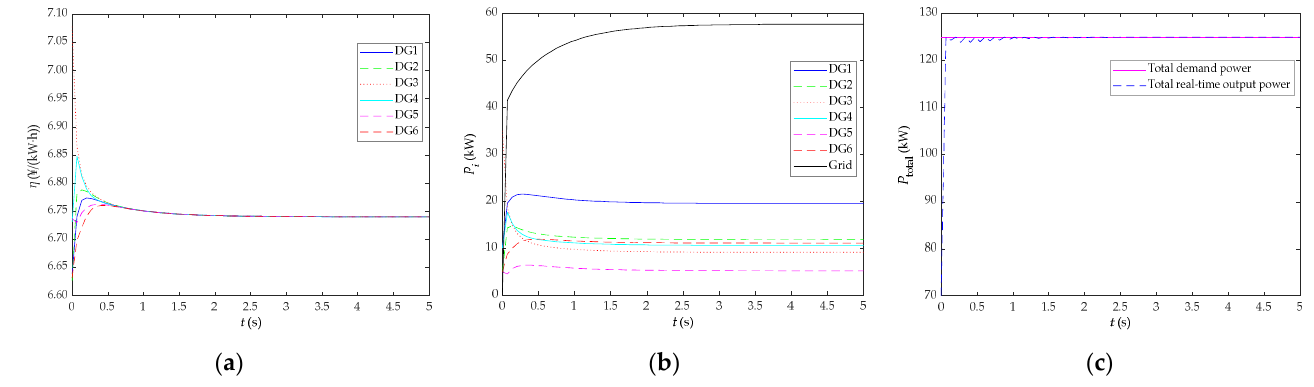
Figure 21. Change curves of variables of the system under the communication topology of low algebraic connectivity: ( a ) change curves of each DG’s ICR; ( b ) change curves of each DG’s active output and grid output power; ( c ) change curves of the cumulative sum of each DG’s active output and grid output power as well as total demand power.